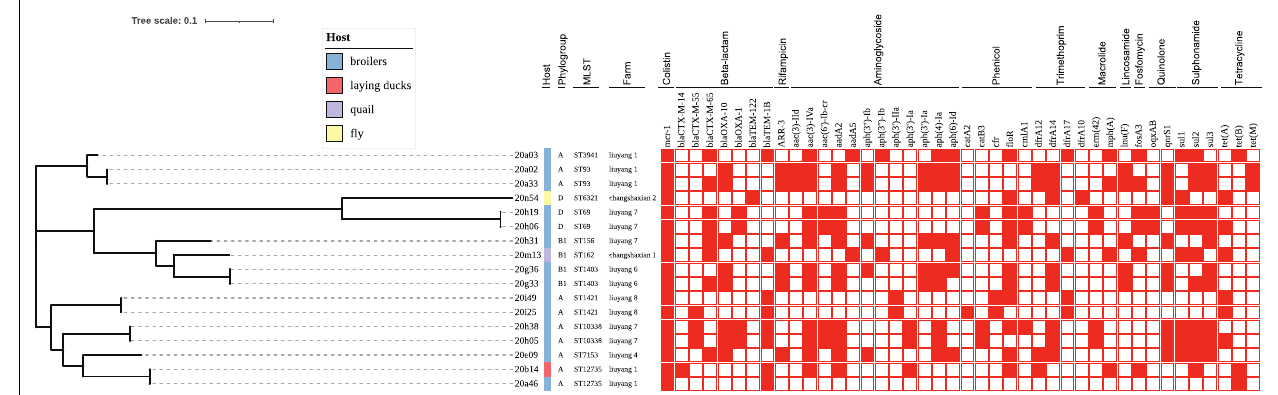
FIGURE 1 | Phylogenetic tree of the 17 mcr -positive Escherichia coli (MCRPEC) isolates. Phylogroup, multilocus sequence type, and farm origin are shown in text after the corresponding isolate name. Sources of the isolates are differentiated by color. Blue, broiler; Orange, laying duck; Purple, quail; Yellow, fly. Filled squares denote the resistance genes for presence and empty squares for absence. TABLE 2 | Minimum inhibitory concentration of 11 antibiotics against MCRPEC.